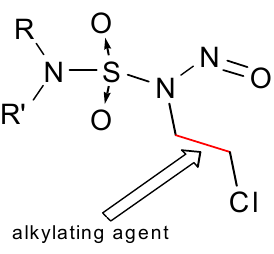
Figure 2: Alkylating moiety in